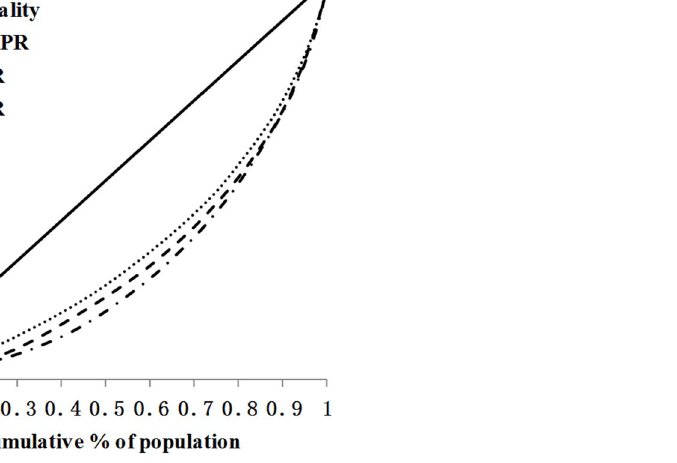
Fig. 2. Lorenz curve of the distribution of health workforce per 10,000 population ratio in Chinese CHS. HWPR: health works per 10,000 population ratio, DPR: doctors per 10,000 population ratio, NPR: nurses per 10,00 population ratio. All CHS centers (n 5 190) are represented in each curve.